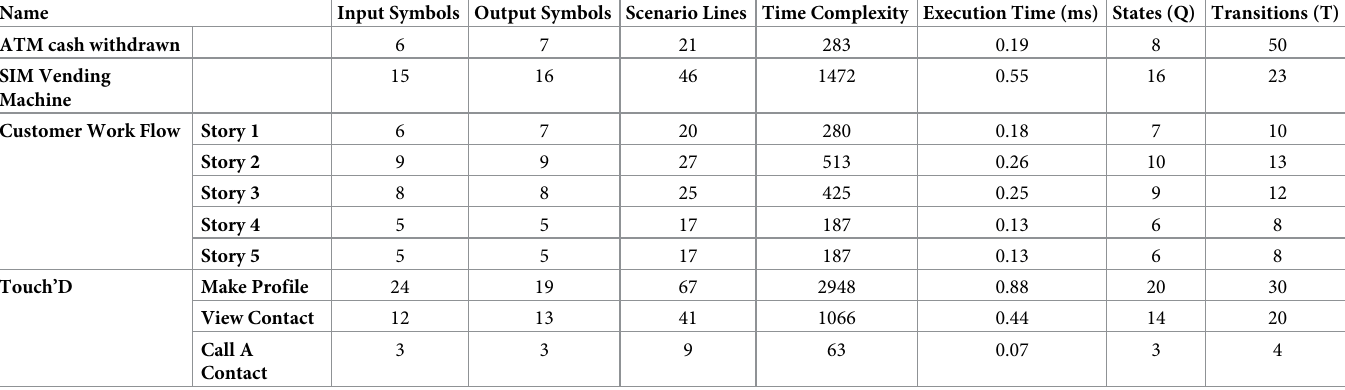
Table 1. Use case parameters and Kripke